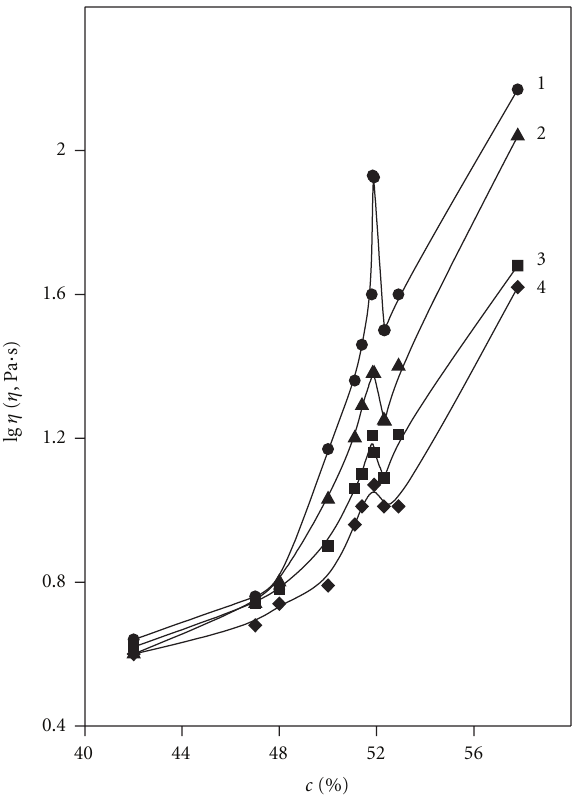
Figure 5: Viscosity versus concentration for aqueous Na-CAS solutions at shear stress τ : 1: 25Pa; 2: 40 Pa; 3: 250Pa; 4: 660Pa ( T = 20 ◦